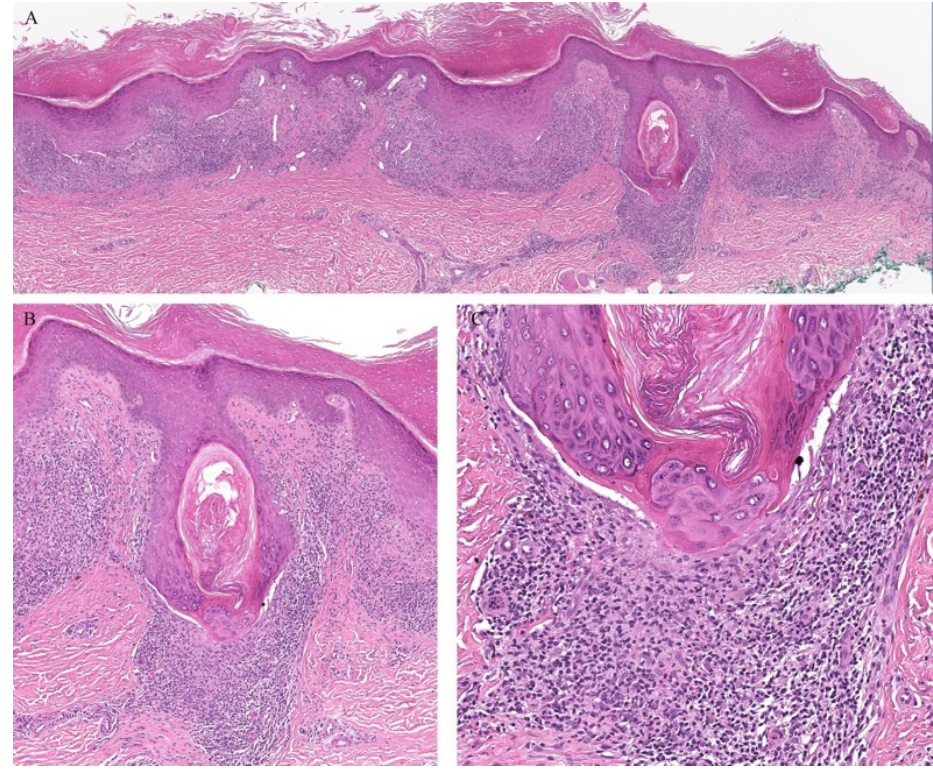
Figure 1. ( A – C ) Lichen planus with follicular